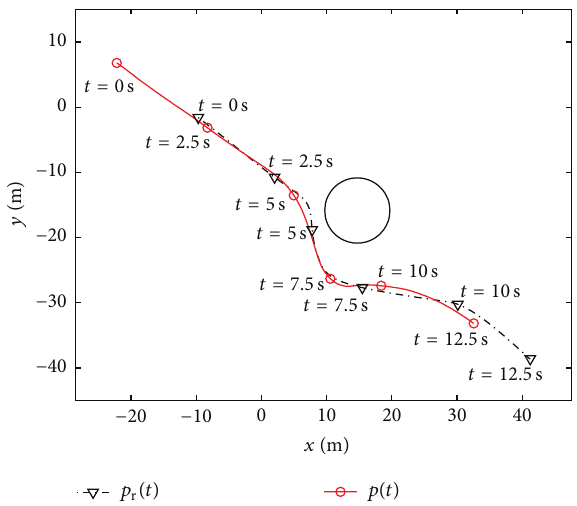
Figure 19: Obstacle avoidance at medium speeds. Triangles and cir- cles denote the location of reference system and vehicle, respectively, at certain instances in time.